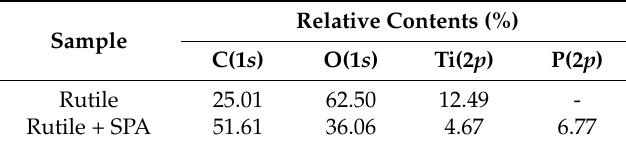
Table 4. Relative content of elements on the rutile